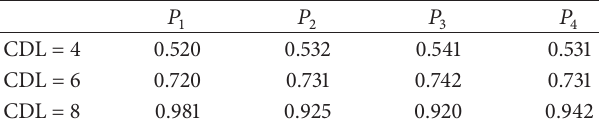
Table 6: CDL assessment outcomes in the elderly.